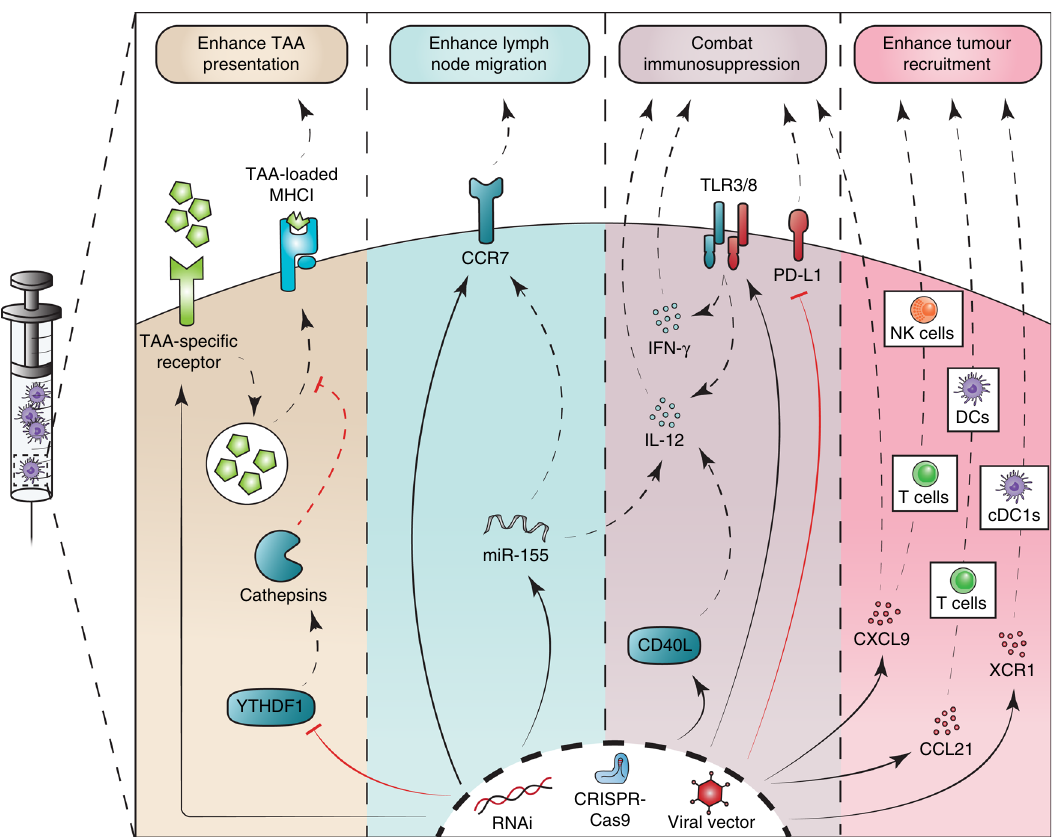
Fig. 1 Genetic approaches for improving dendritic cell-based vaccines. RNA interference (RNAi), clustered regularly interspaced short palindromic repeats (CRISPR)/CRISPR-associated protein 9 (Cas9), or viral transduction may be used to modulate expression of different targets and modulate various pathways of anti-tumour immunity. Solid arrows indicate direct genetic targets, while dashed arrows indicate downstream effects. (i) Enhancing tumour- associated antigen (TAA) presentation: expression of an engineered receptor (e.g., extracellular vesicle-internalizing receptor, EVIR) promotes in situ antigen uptake and increases presentation of relevant TAAs 71 ; silencing of YTHDF1 reduces translation of lysosomal cathepsins, decreasing antigen degradation after internalization and improving cross-presentation capacity 76 . (ii) Enhancing lymph node migration: direct overexpression of CCR7 improves lymph node migration 63,87 ; alternatively, overexpression of miR-155 upregulates CCR7 and IL-12 secretion 29,88,90 . (iii) Abating immunosuppression: silencing dendritic cell (DC)-intrinsic immunosuppressive molecules, such as PD-L1, improves T cell activation capacity 79 ; upregulation of IL-12, IFN- γ , or CXCL9 improves immune checkpoint blockade 22,27,31 , which can be achieved via direct overexpression of these signals 80,81 , via activation of TLR3 and TLR8, which induces IL-12 and IFN- γ release 49,52,69 , or via CD40 agonism through transgenic expression of CD40L that activates IL-12 release 31,64,68,82 . (iv) Enhancing immune cell recruitment: upregulation of different chemokines at the tumour site drives recruitment of various immune cells, including CXCL9-driven recruitment of CXCR3 + T cells and natural killer (NK) cells 24,83 , CCL21-driven recruitment of CCR7 + DCs and T cells 91,92 , and XCL1-driven recruitment of XCR1 + cDC1s 26